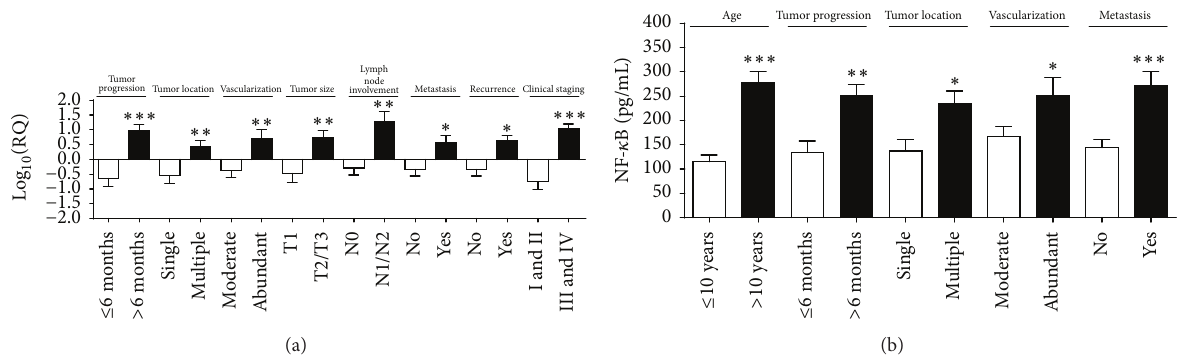
Figure 1: NF- 𝜅 B gene overexpression correlated with (a) tumor progression greater than 6 months; multiple tumor locations; abundant tumor vascularization; tumor mass size greater than 3 cm; lymph node involvement; presence of metastasis; recurrence and clinical staging III or IV. Higher NF- 𝜅 B protein levels correlated with (b) with age > 10 years; tumor progression greater than 6 months; multiple tumor locations; abundant tumor vascularization; and presence of metastasis. Error bars ± standard error; ∗ 𝑝 < 0.05 ; ∗∗ 𝑝 < 0.01 ; ∗∗∗ 𝑝 < 0.001 indicate significant differences according to Student’s 𝑡